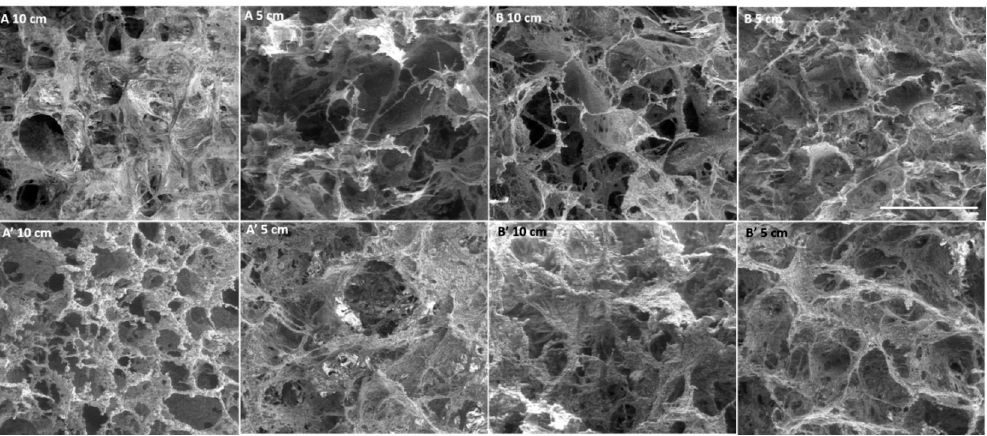
Figure 1. SEM images of Coll/nanoHA scaffolds A–B and A’–D’. Scale bar: 500 μ m.